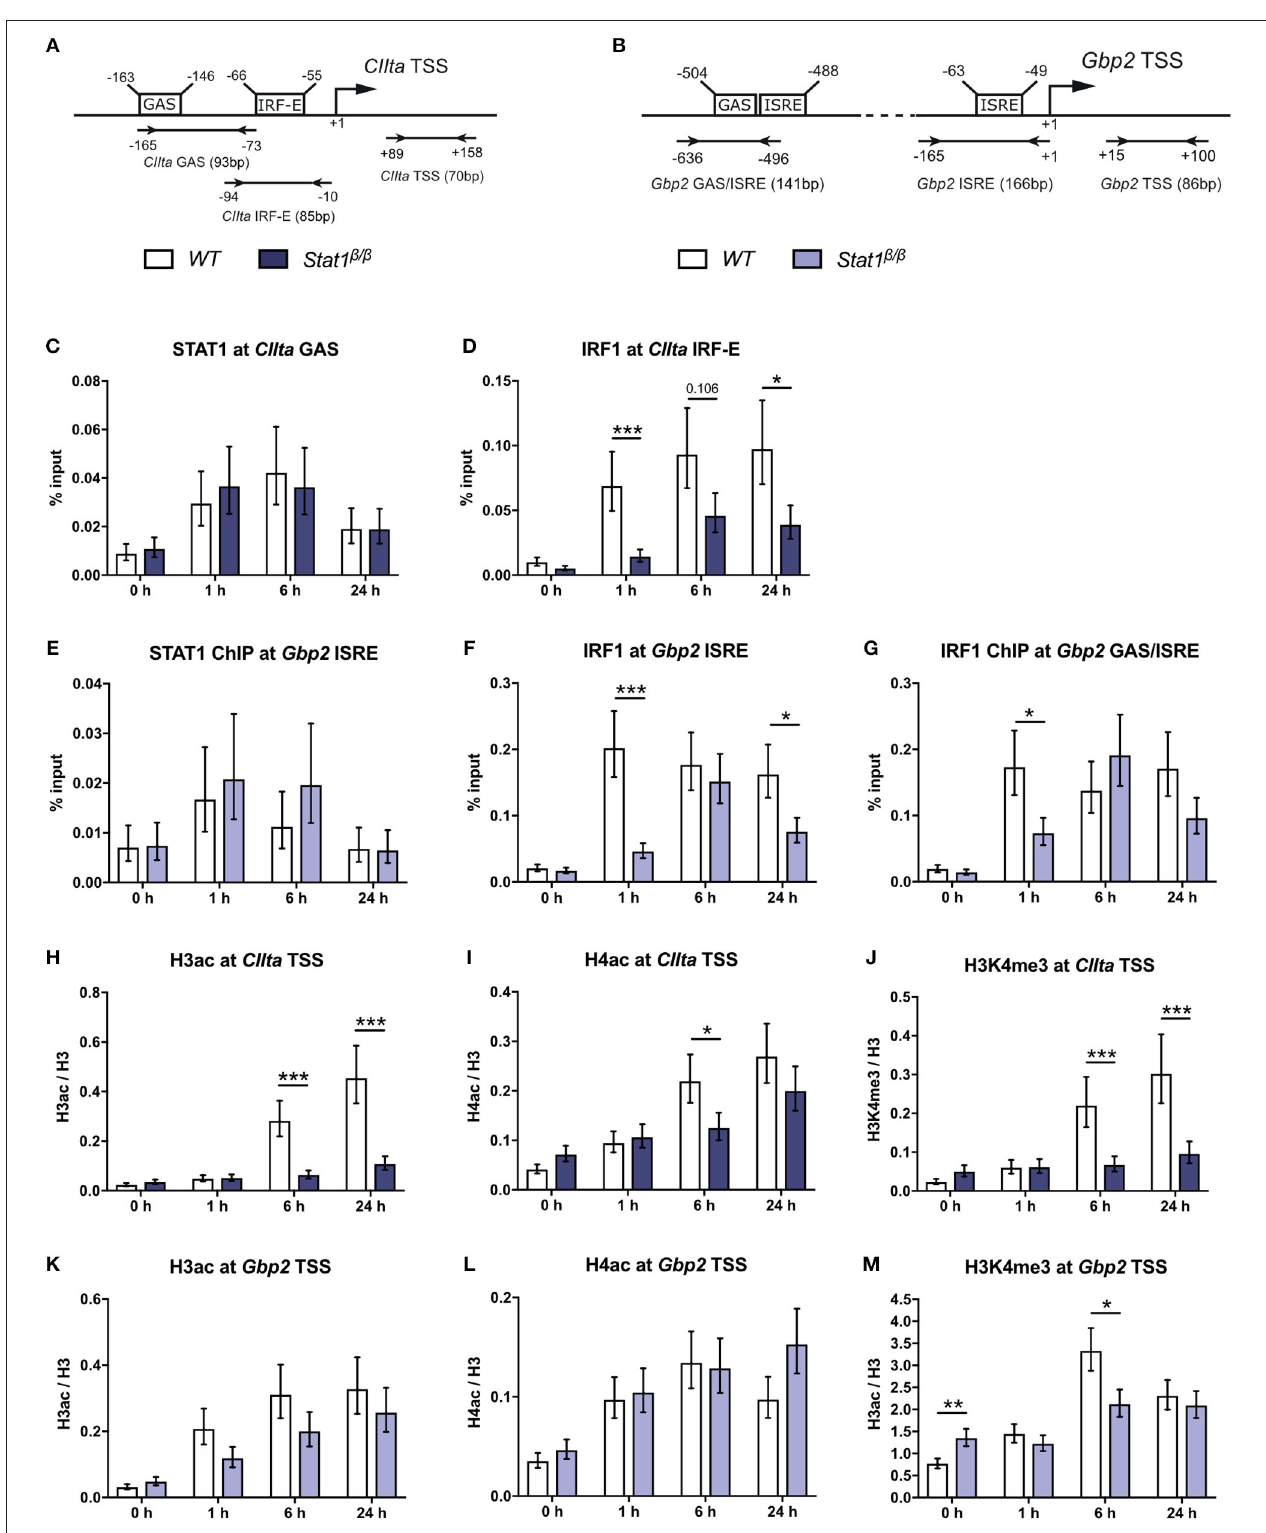
FIGURE 2 | STAT1 and IRF1 binding to the CIIta promoter IV (pIV) and the Gbp2 promoters and IFN γ -induced histone modifications. (A,B) Schematic representation of the murine CIIta and Gbp2 promoter regions. STAT1 and IRF1 binding sites, the TSS, and the position of the primers used for the ChIP analyses are